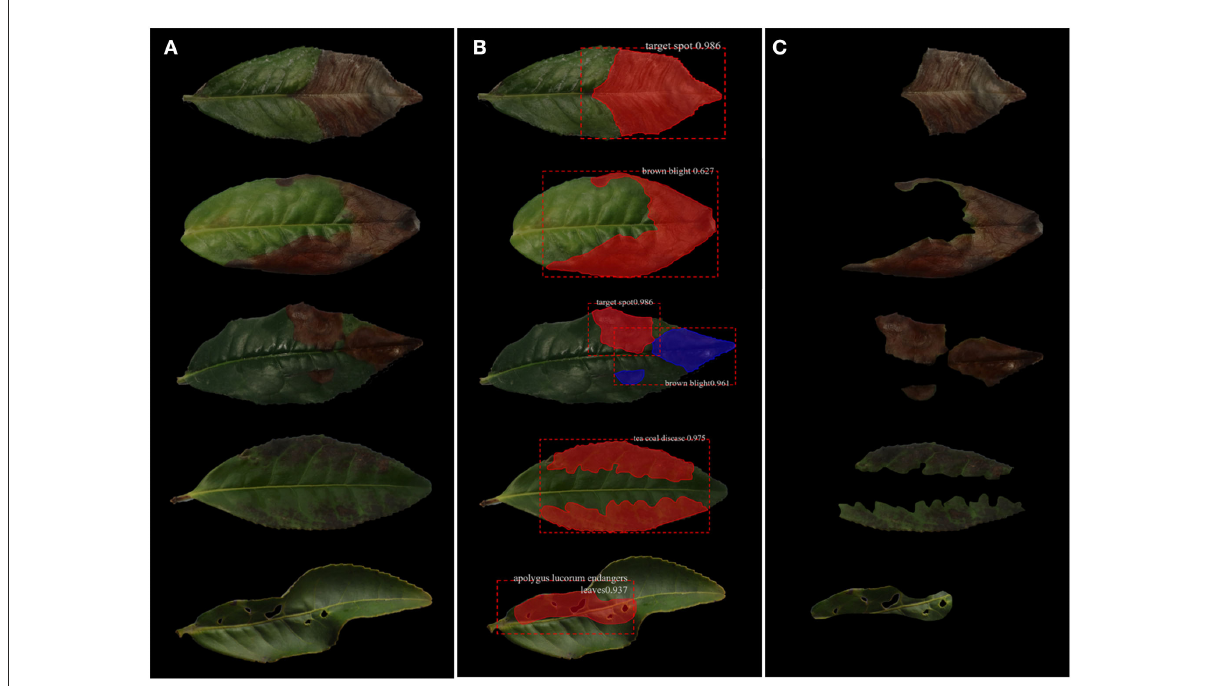
FIGURE9 Segmentation process of tea leaf disease spots and insect damage spots. (A) Original image; (B) identified image; and (C) segmented image.